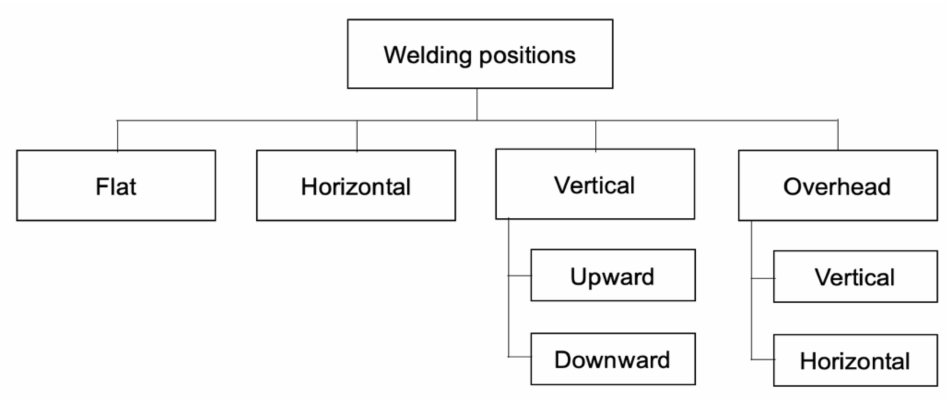
Figure 4. Reclassification of welding positions for shipbuilding block assembly